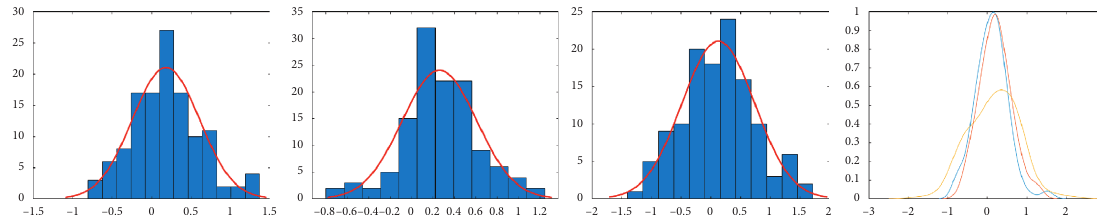
Figure 9: Standard deviation and normal distribution curve of pair 1, pair 2, and pair 3.